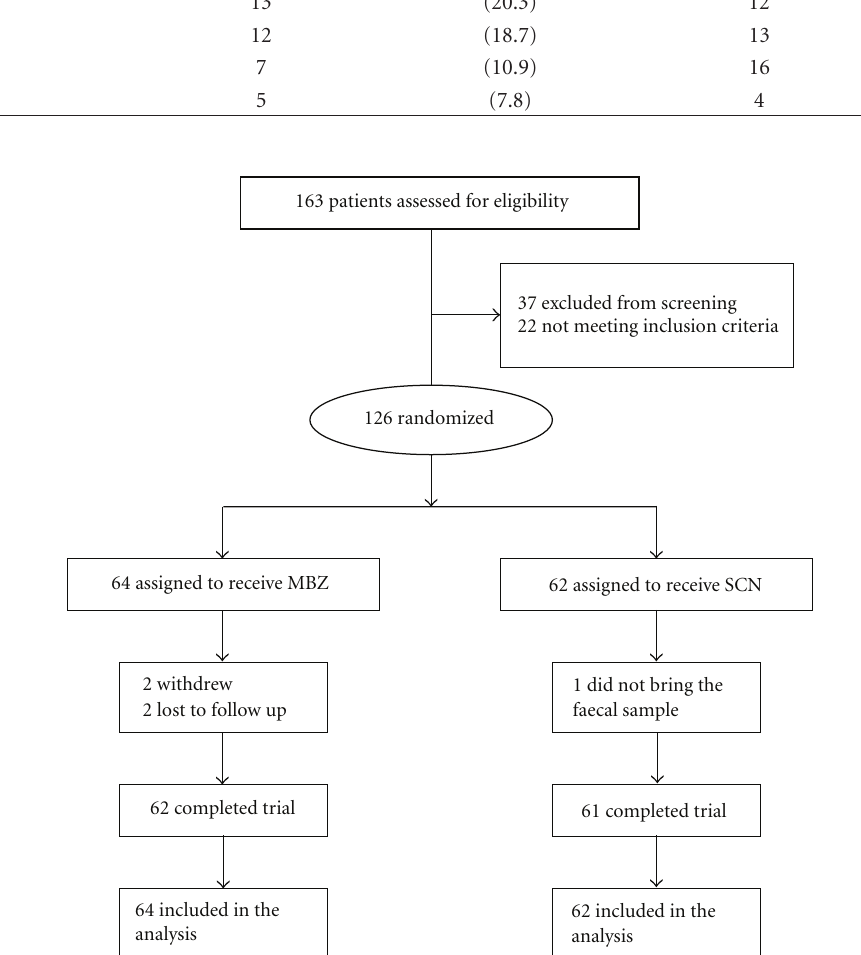
Figure 1: Flow diagram of the clinical trial